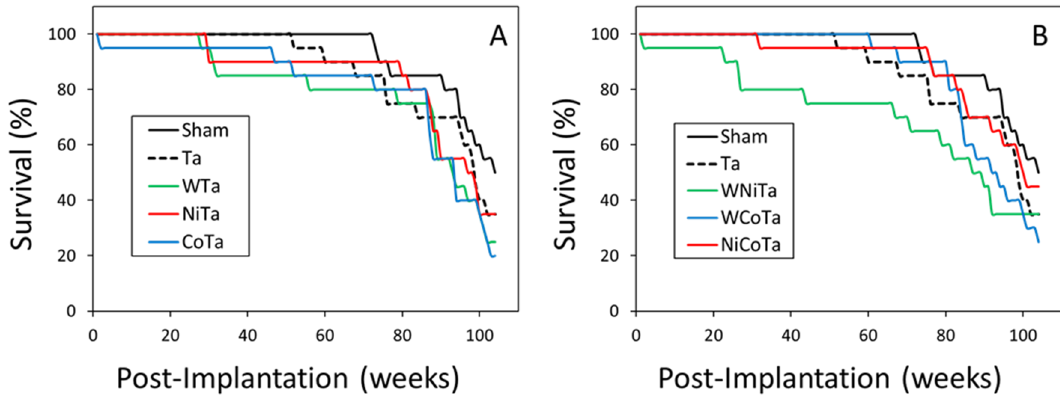
Figure 2. Kaplan–Meier survival plots for the one-metal ( A ) and two-metal ( B )